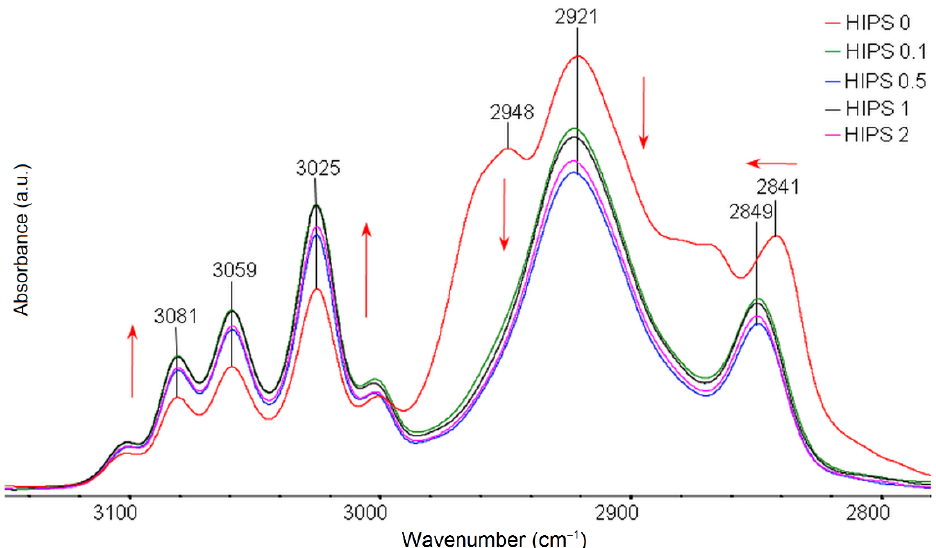
Figure 4. Summary of FTIR spectra for pure HIPS filaments and HIPS filaments with the addition of rGO in a range of 3150–2780 cm − 1 .